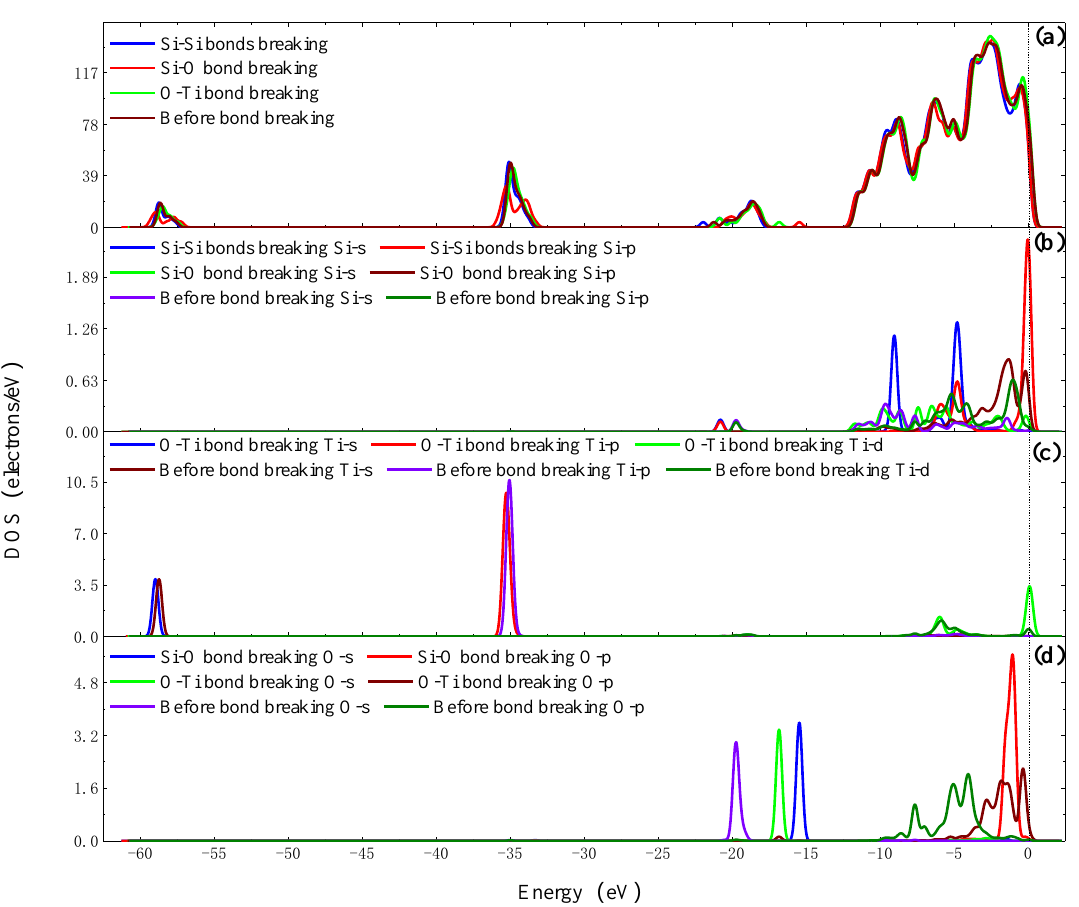
Figure 11. The DOS of TiO 2 cluster separating from the Si surface. ( a ) Total DOS; ( b ) PDOS of adsorption site Si atoms; ( c ) PDOS of adsorption site Ti atoms; ( d ) PDOS of adsorption site O atoms.